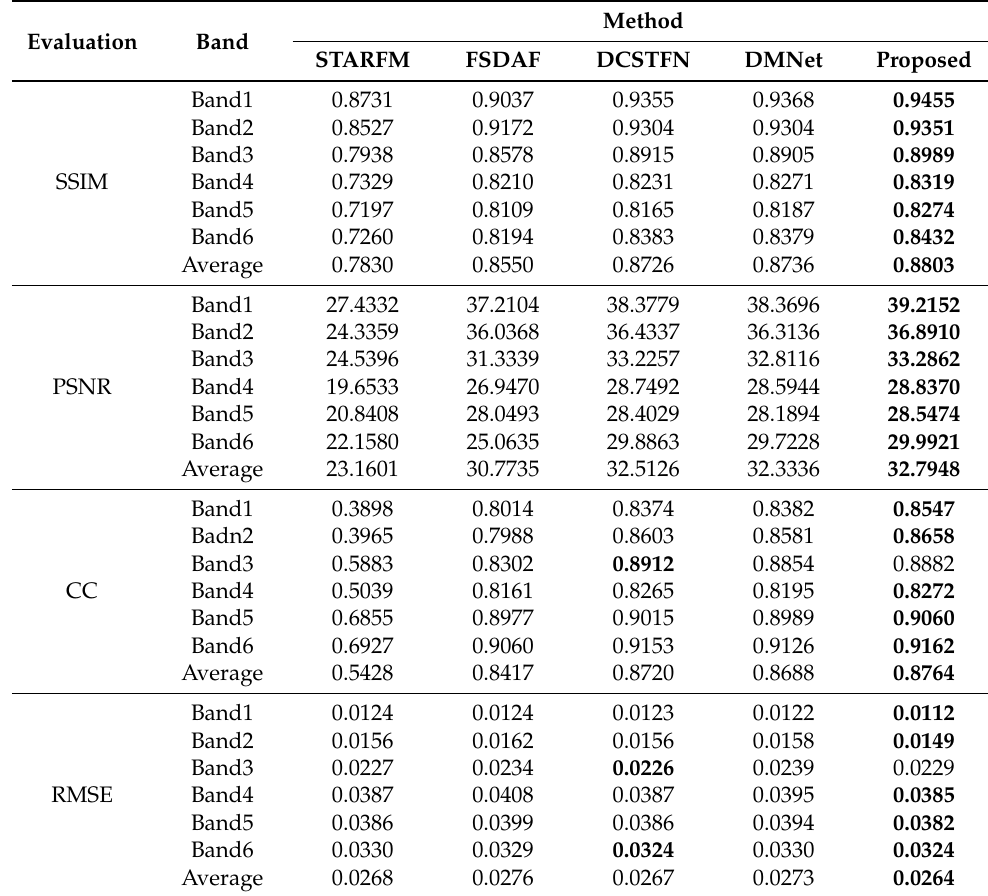
Table 1. Quantitative assessment of different STF methods on the CIA [46] dataset.